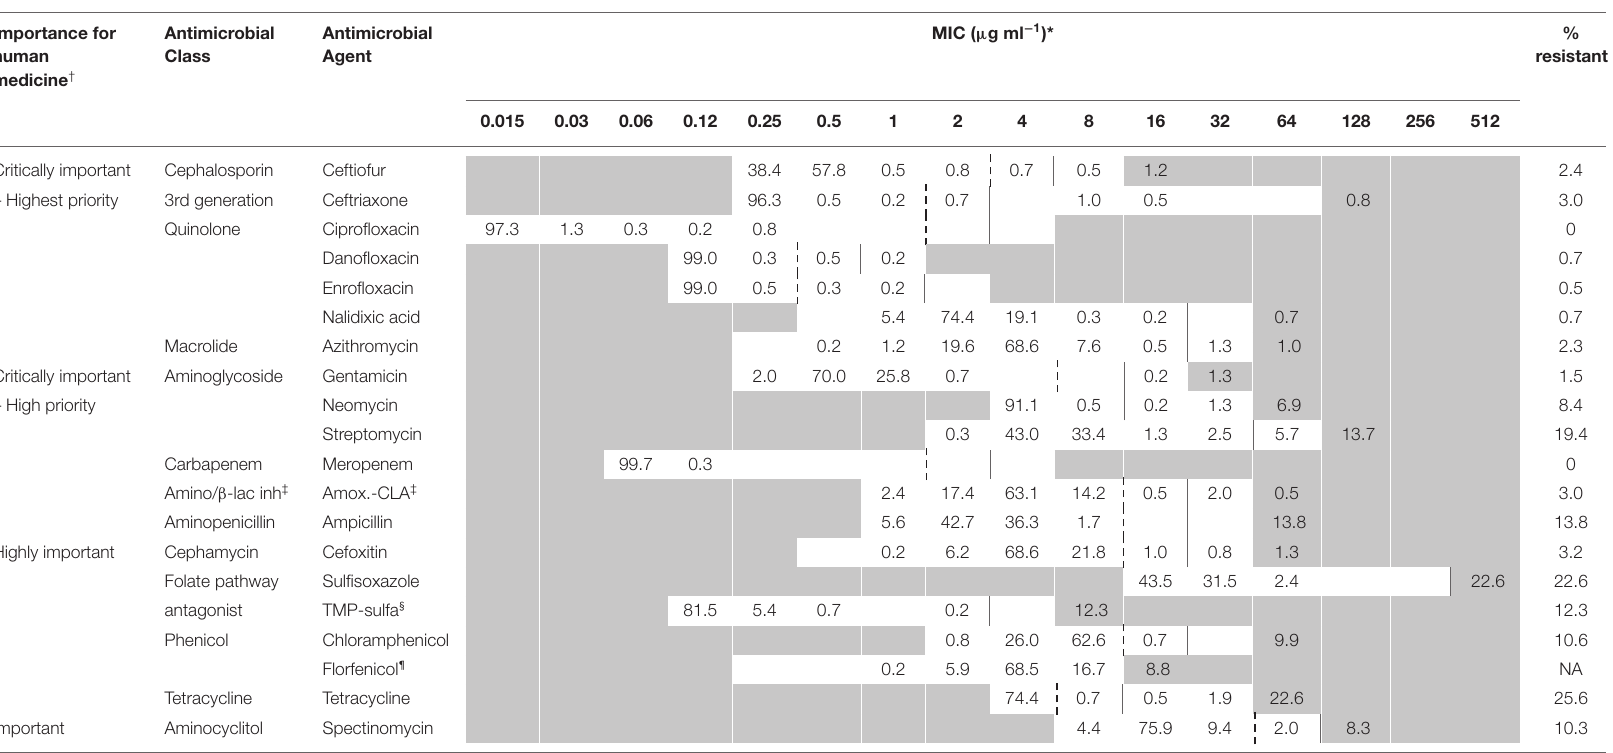
resistant isolates were grouped together and labeled as resistant for the last column of the table; † Importance of antimicrobials according to World Health Organization (15). ‡ Penicillin + β -lactamase inhibitor: Amoxicillin/clavulanic acid combination; § Trimethoprim-sulfamethoxazole combination; ¶ Florfenicol has no valid clinical breakpoints for Enterobacteriaceae and the concentration of 0.25 to 4 µ g mL − 1 did not include the European epidemiological breakpoint of 16 µ g mL − 1 , thus no interpretation could be